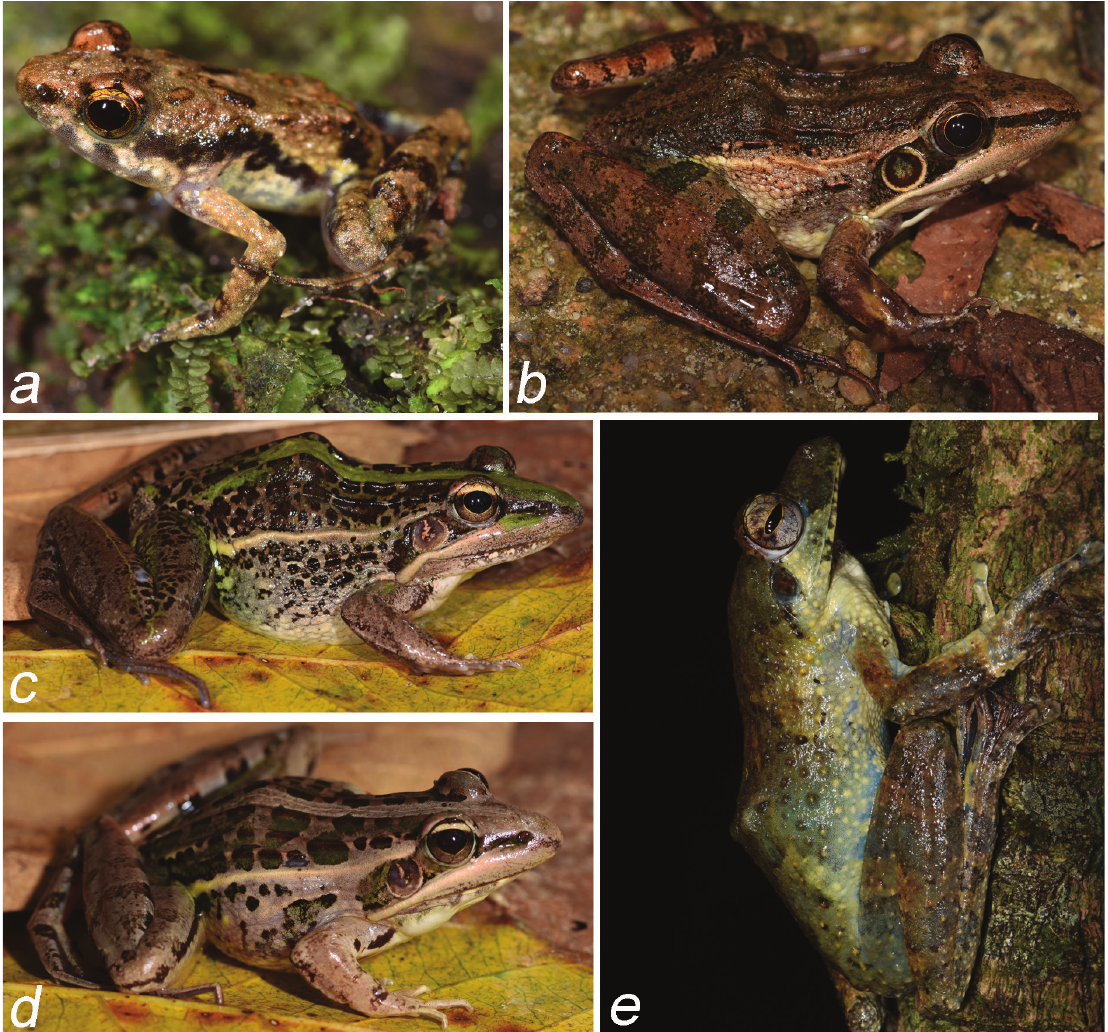
Figure 5. a Undescribed Phrynobatrachus sp. from KBPPA exhibiting characters of P. gutturosus and P. tokba b Ptychadena sp. male (ZMB 88505) from river bank in FPPA c, d Ptychadena mascareniensis -complex females with green (c: ZMB 88535) and brown (d: ZMB 88537) vertebral bands from the same rice paddy in FPPA e Chiromantis rufescens female (not collected) from